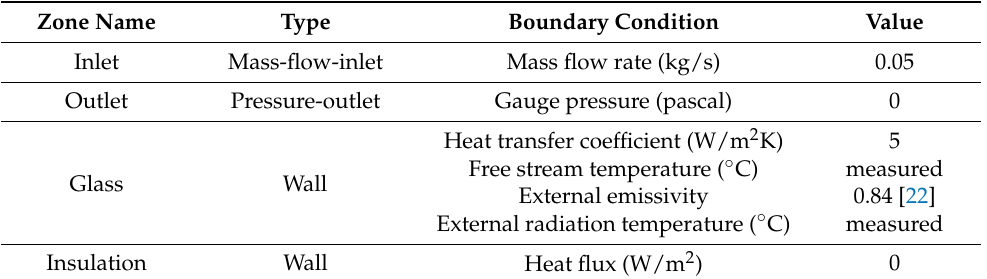
Table 2. Boundary